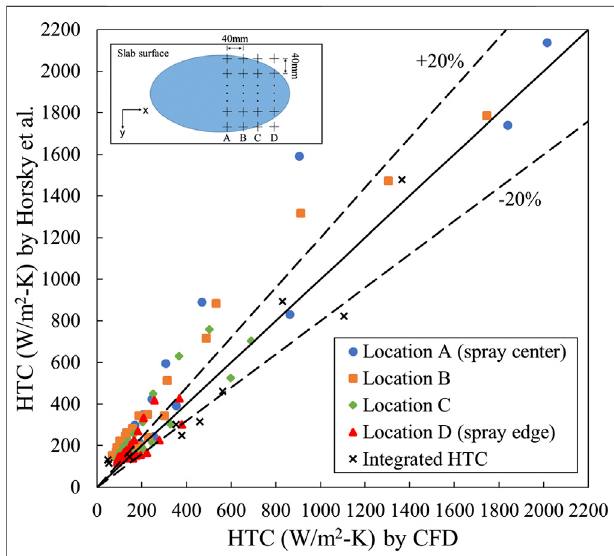
FIGURE 8 | Comparison of HTC on the steel